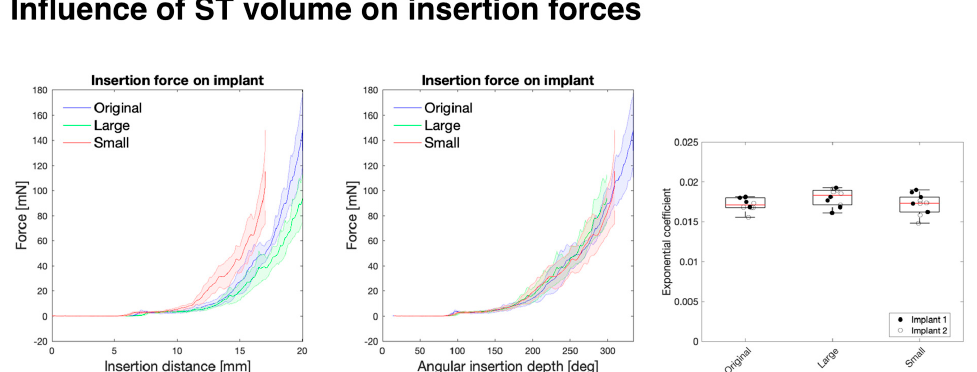
Figure 3. Influence of ST overall size on insertion forces. A volumetric scaling of the ST model was conducted to produce a “large” (110% the volume of the “original”) and ”small” (90% of the “original” model) models. Whereas a significant difference is seen when plotting force exerted on the CI (mean-solid line; shaded area-standard deviation) with respect to insertion distance ( left ), these force profiles overlap when plotting relative to angular insertion depth of the round window ( middle ). The exponential coefficients ( right ) of the Capstan model fitting to the force on the implant with respect to the angular insertion depth illustrate no significant difference ( p > 0.05) between the insertion force profiles. Boxplot: red line-median, box-interquartile range (n = 10 replicates combined over N = 2 implants).